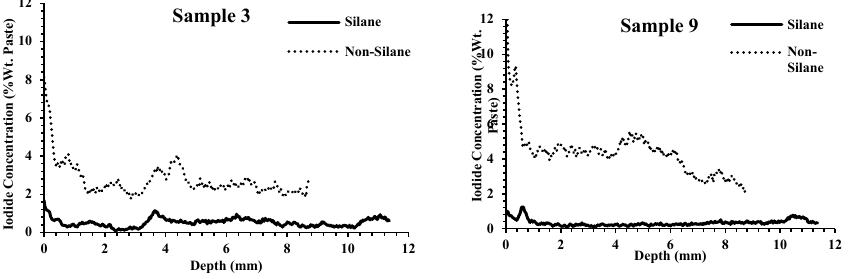
Figure 6. Iodide concentration profiles of Samples 3 and 9.